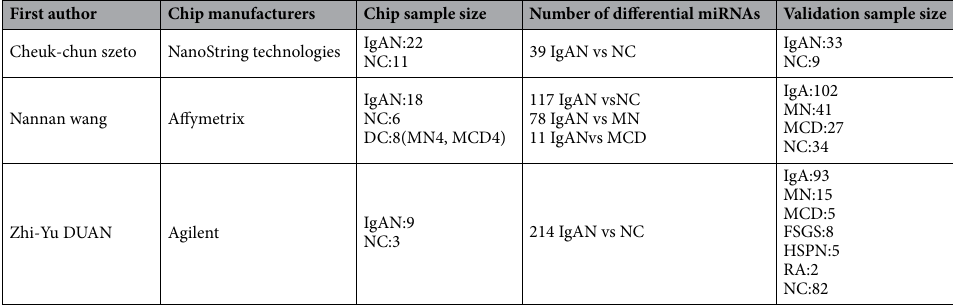
Table 1. Comparison of the three miRNA profiles from the existing research. IgAN, IgA nephropathy; NC, normal controls; DC, disease controls; MN, membranous nephropathy; MCD, minimal change disease; FSGS, focal segmental glomerular sclerosis; HSPN, Henoch-Schonlein purpura nephritis; RA, renal